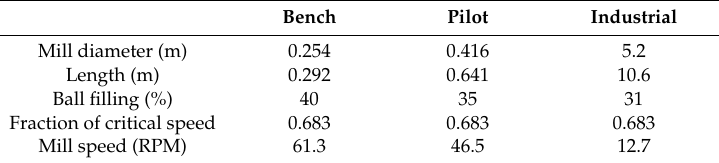
Table 1. Summary of mill characteristics and operating conditions.